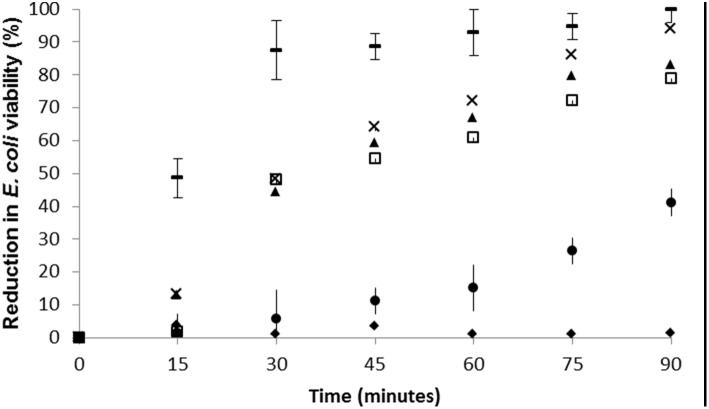
The biocidal effect of differing Cu concentrations entrapped in alginate beads on E. coli ATCC 11775 over time.Black diamond = Plain alginate beads. White square = 1% Cu W:W. Black triangle = 2% Cu. Black cross = 3% Cu, Black dash = 4% Cu. Black circle = 4% copper powder not associated with alginate. Bars denote standard errors.